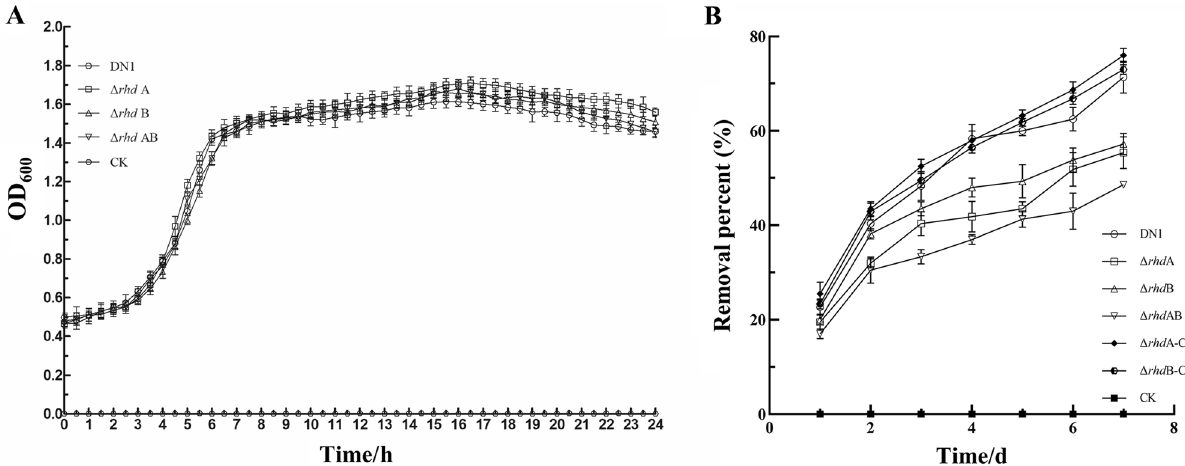
Figure 1. Growth curves in LB medium ( A ) and removal percent during growth period of the strain DN1, and its mutants and the complemented strain ( △ rhd A-C and △ rhd B-C) in the presence of 50 μg/ml fluoranthene ( B ). The values presented are the average ± standard deviation of experiments run in triplicate. The open symbols stands for growth curves of those strains, and the filled symbols stands for the removal percent of fluoranthene, respectively. CK represented the cultures without cell inoculum in ( A ) and cultures containing fluoranthene without inoculum in ( B ). These samples were used as